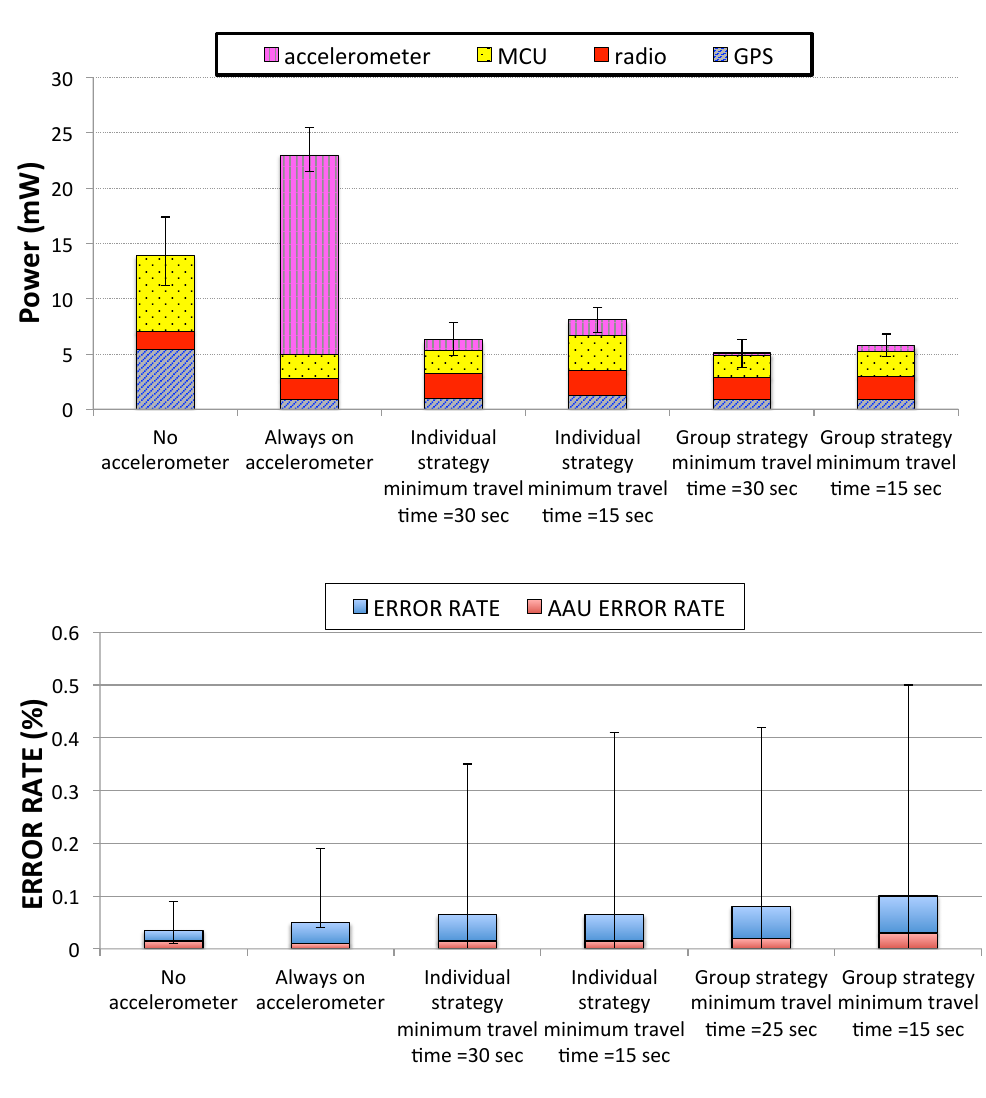
Figure 23. Power consumption and accuracy for the 3-hour interval in the data trace with the fewest number of motion